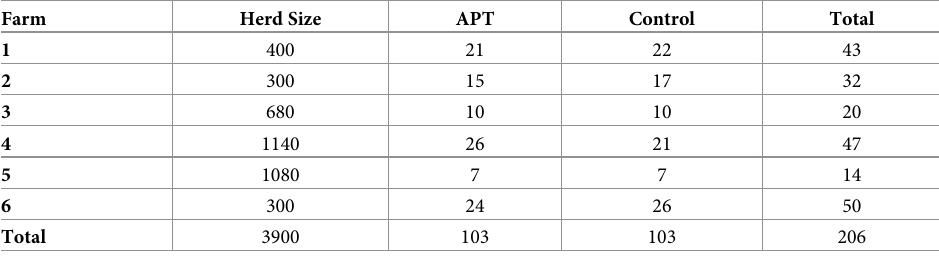
Table 1. The significance ( P values) of the ANOVA results for the day effect and the R 2 . Farm Herd Size APT Control Total 1 400 21 22 43 2 300 17 32 3 680 10 4 1140 1080 300 Total 3900 103 103 206 APT–acoustic pulse